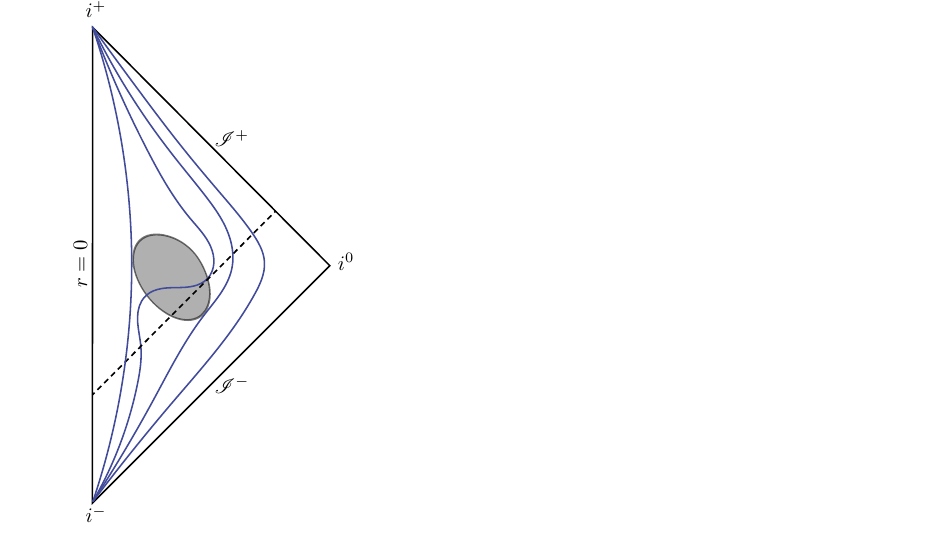
Figure 4. Causal diagram of an evaporating regular black hole. The shaded region represents the black hole trapped region. The blue curves joining i − and i + qualitatively represent r = const.